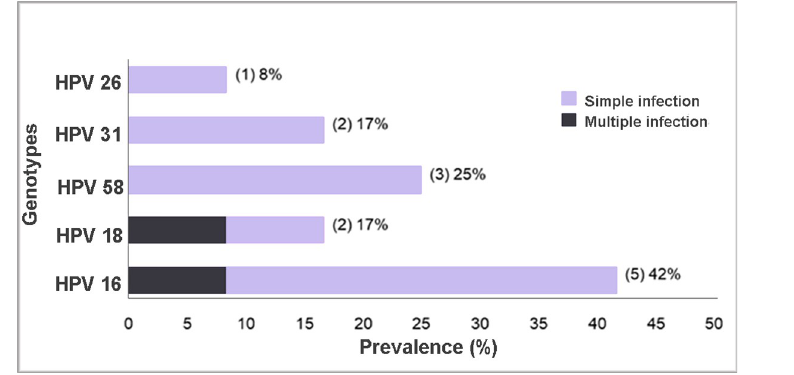
Fig 2. Genotypic prevalence of Human papillomavirus (HPV) in colorectal cancer (CRC).